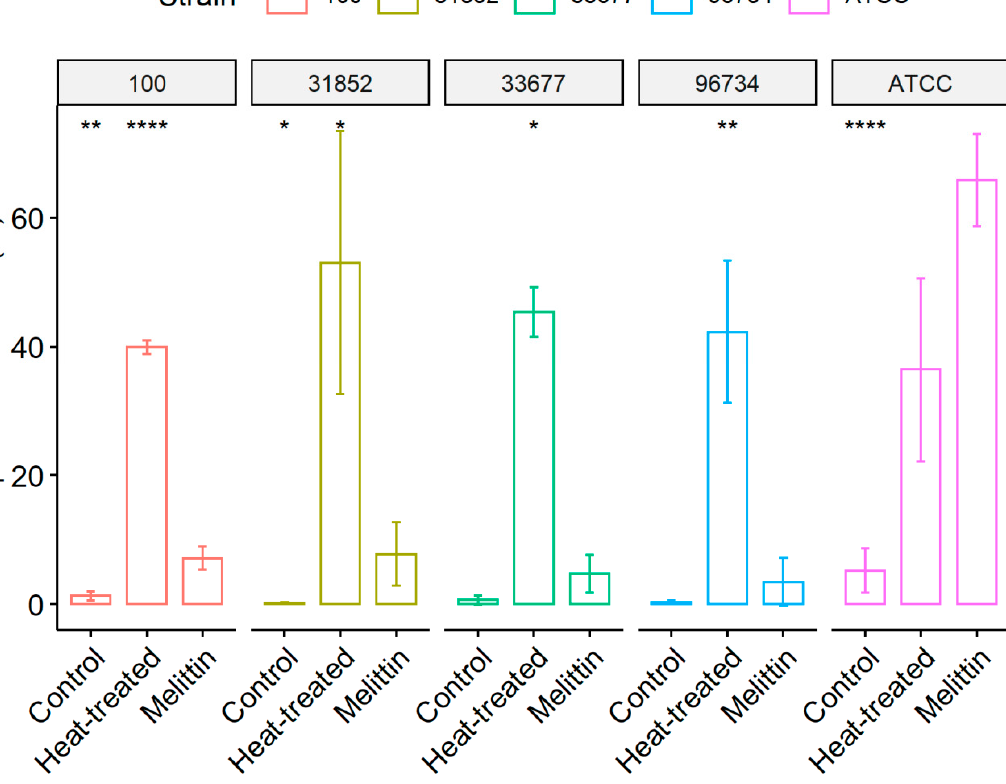
Figure 2. E ff ect of melittin in bacterial membrane permeability. Di ff erent A. baumannii strains were treated with melittin (142 µ g / mL) for 2 h or heat-treated at 65 ◦ C for 15 min, then incubated with the nucleic acid probe propidium iodide (PI; 30 µ M), as a membrane permeability indicator. Bars indicate the percentage of PI fluorescent bacteria in the untreated group, treated with melittin or heat-treated. Results represent the mean and standard deviation. Statistically di ff erent (* p < 0.05, ** p < 0.01 and **** p < 0.001) from melittin group using t